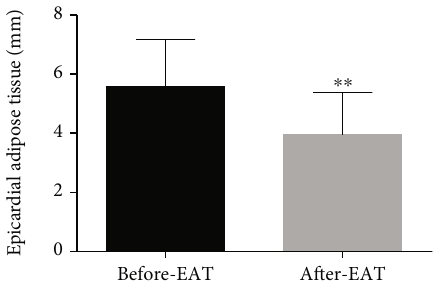
Figure 4: EAT thickness was decreased when liraglutide was introduced. 1.5T cardiac magnetic resonance imaging (MRI) was used to measure the thickness of EAT ( ∗∗ p < 0 : 01